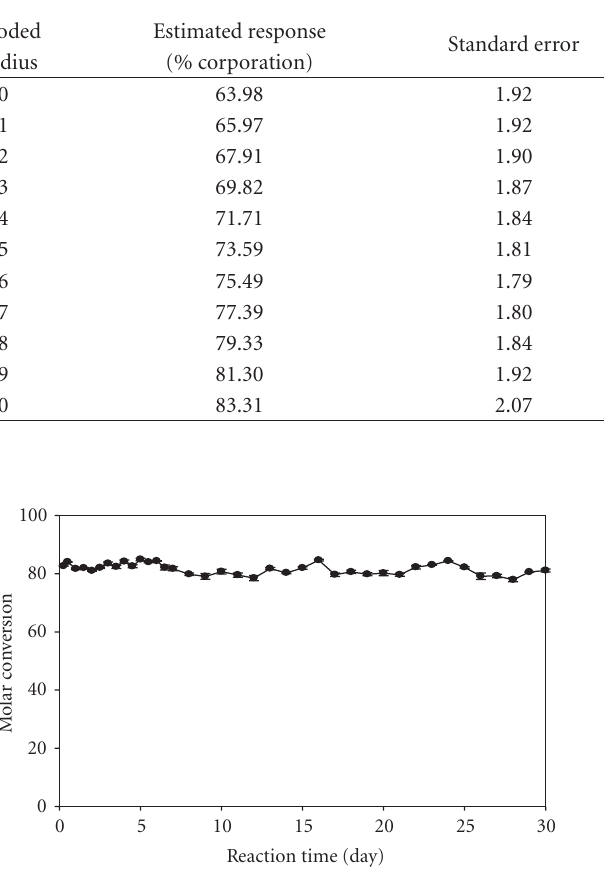
Figure 3: The e ff ects of operating time on the conversion of soybean oil to biodiesel. Reaction conditions: temperature 52.1 ◦ C, flow rate 0.1mL/min, substrate molar ratio 1: 4, and 1.7 g